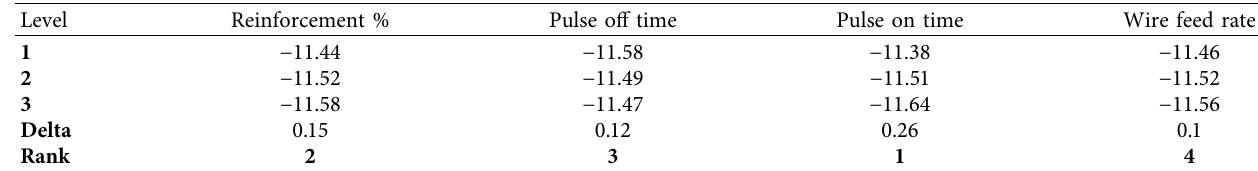
Figure 4: Effect of control factors on surface roughness. Table 3: Response table for surface